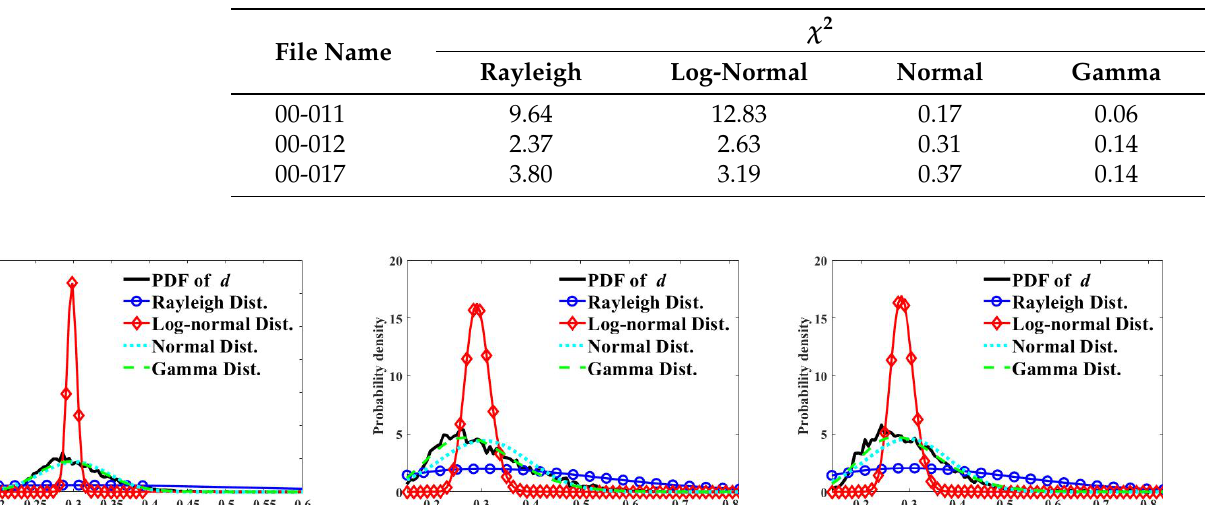
Table 2. Fitting error using Chi-Squared test on d in Figure 4.